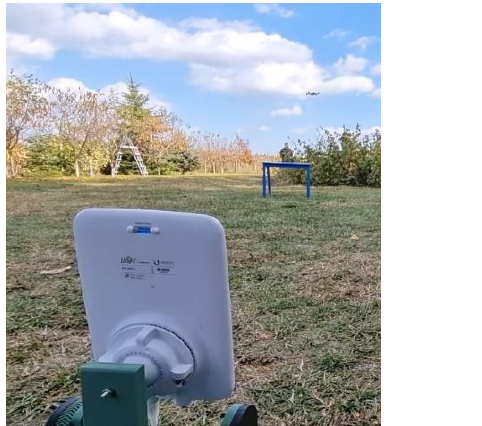
Figure 4. The linear antenna system that was used and the USRP X310 SDR platform during the calibration procedure of the Twin-RX RF modules.